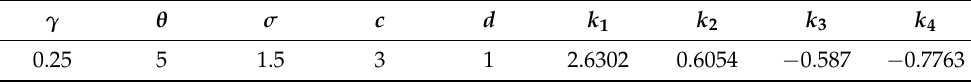
Table 4. Chaos generator’s coefficients of the second transmitter.